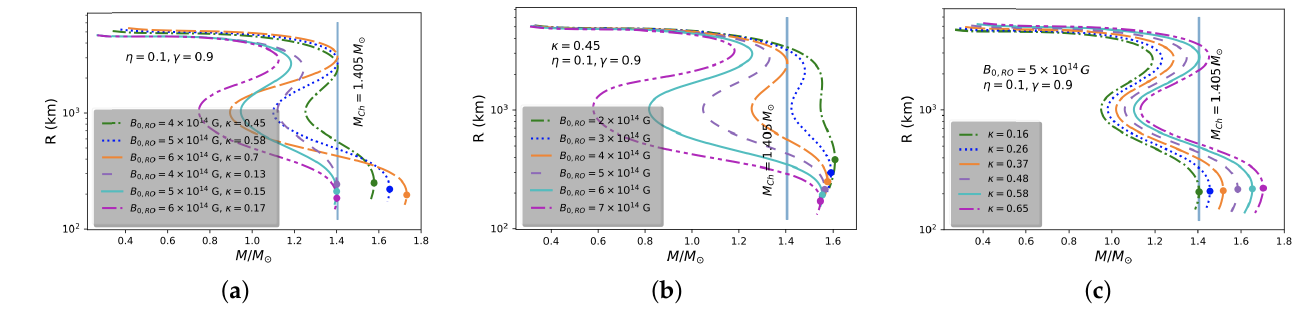
Figure 11. Stellar radius ( R ) as a function of gravitational mass ( M / M (cid:12) ) for varying ( a ) B 0, RO and κ (left panel), ( b ) B 0, RO (middle panel), and ( c ) κ (right panel). Solid circles represent the stars with the maximum possible masses. See